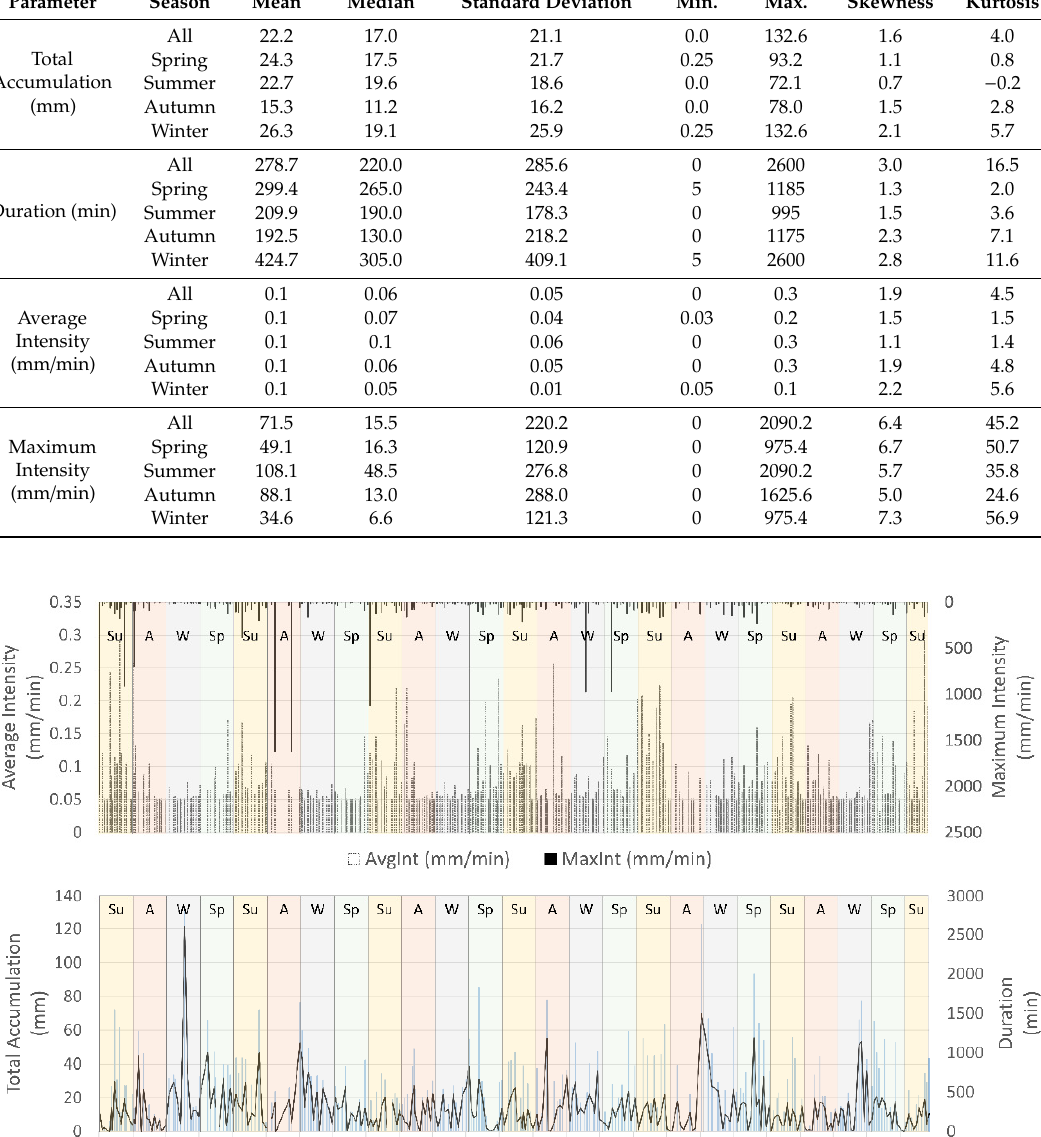
Table 1. Descriptive statistics of precipitation parameters by measurement period.